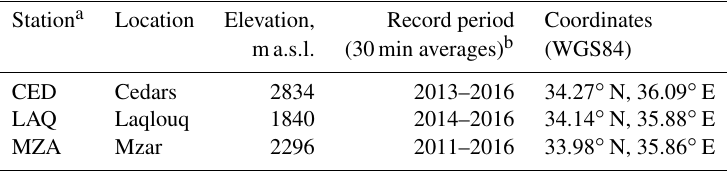
Table 2. Meteorological stations.